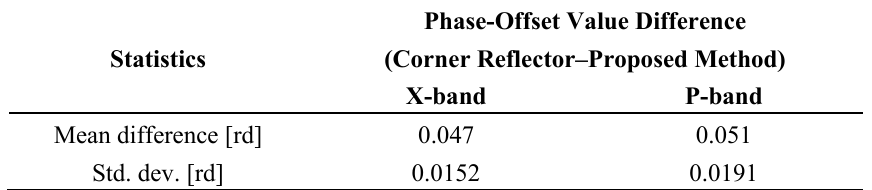
Table 3. Phase-offset error between the two phase-offset estimation methods.